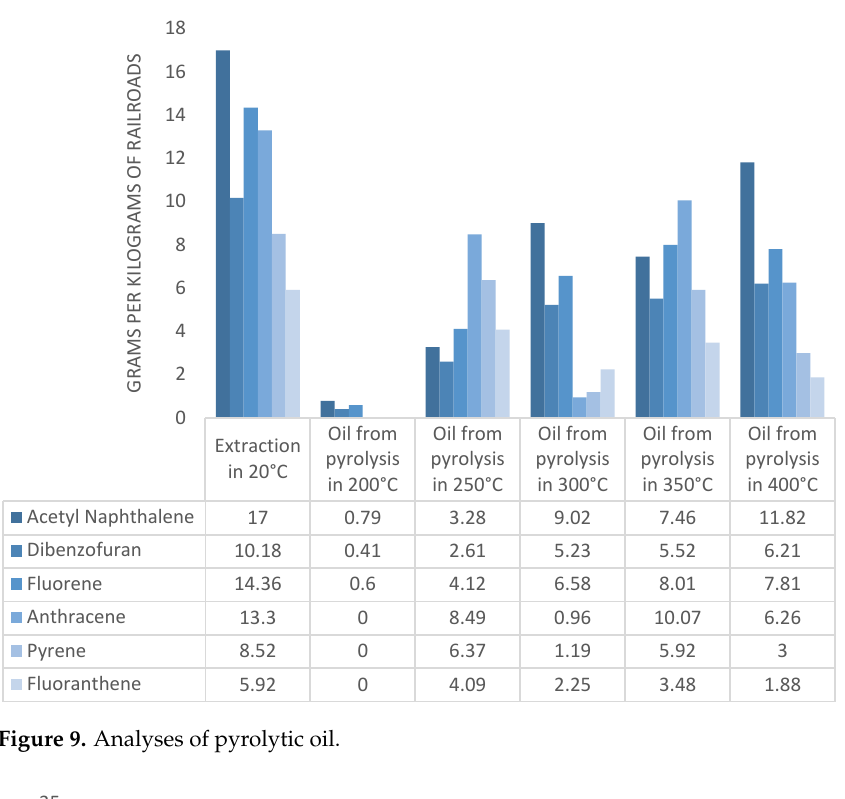
Figure 9. Analyses of pyrolytic oil.